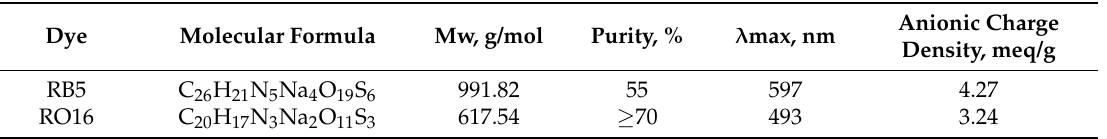
Table 2. Physical properties of dyes.